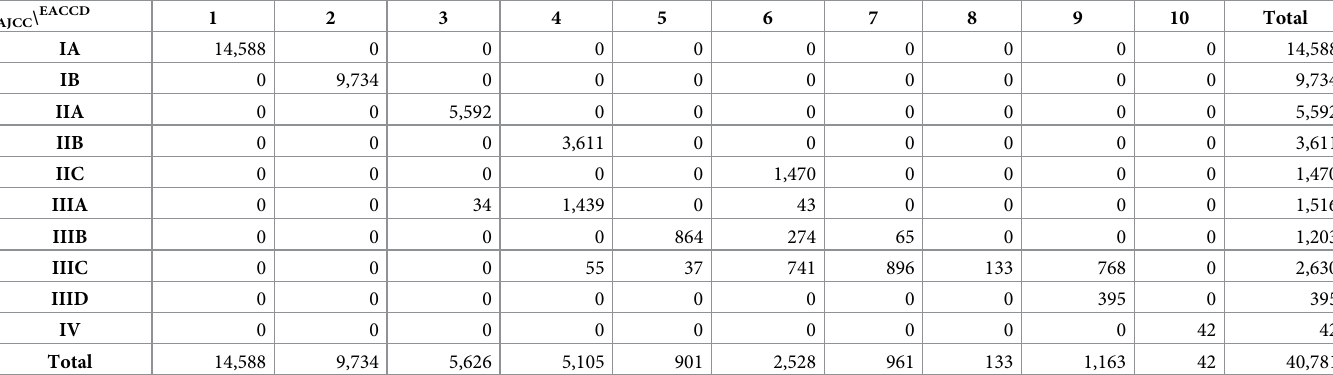
Table 3. Contingency table between EACCD grouping and AJCC staging on the basis of T, N, M on the training